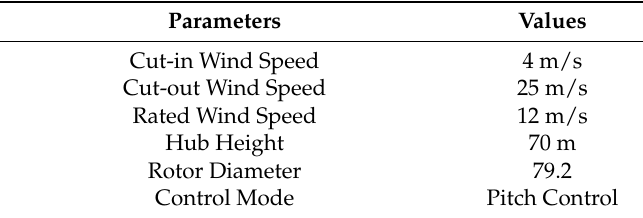
Table 1. Wind turbine (WT) technical